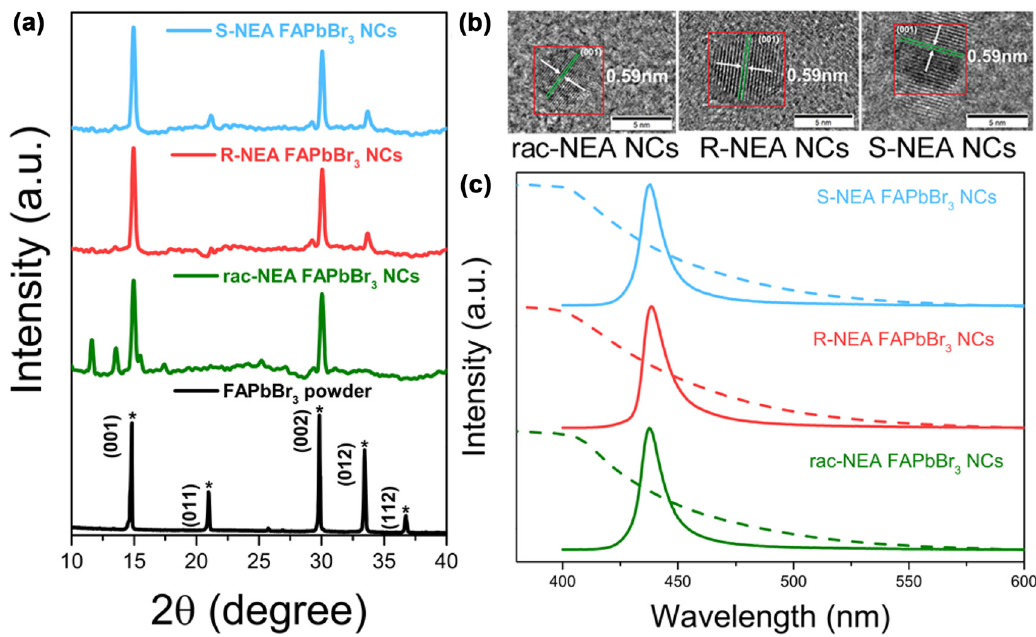
Figure 1: Characterization of the morphology and properties of S/R/rac-NEA-coated FAPbBr3 NCs. (a) XRD spectra and (b) TEM micrographs NCs coated with different NEA ligands; (c) absorption spectra (dotted lines) and photoluminescence spectra (solid lines, of FAPbBr 3 NCs coated with different NEA excitation wavelength of 365 nm) of FAPbBr 3